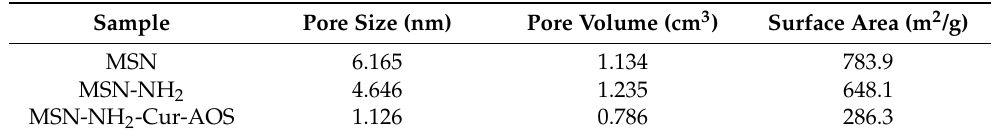
Figure 6. N 2 -adsorption and desorption curves for MSN ( a ), MSN-NH 2 ( b ), MSN-NH 2 -AOS ( c ), and MSN-NH 2 -Cur-AOS ( d ). Table 3. The corresponding parameters of N 2 adsorption and desorption.